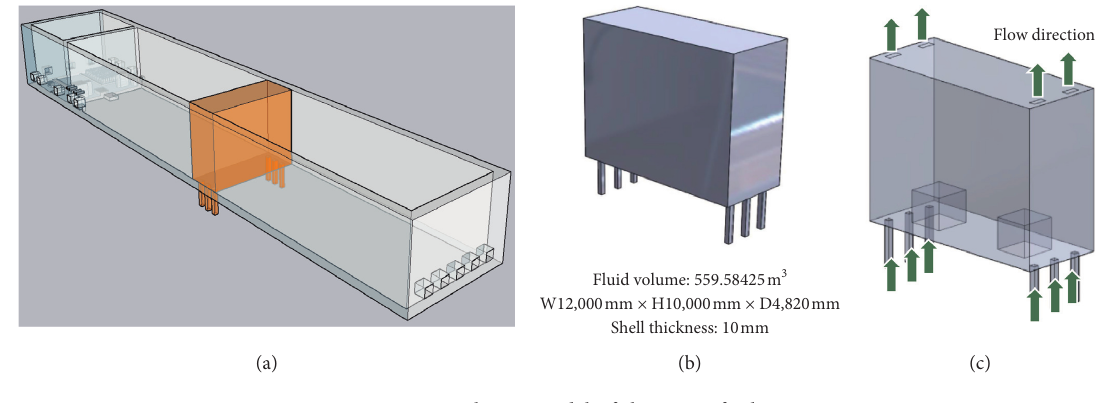
Figure 9: Simulation model of the target facility.